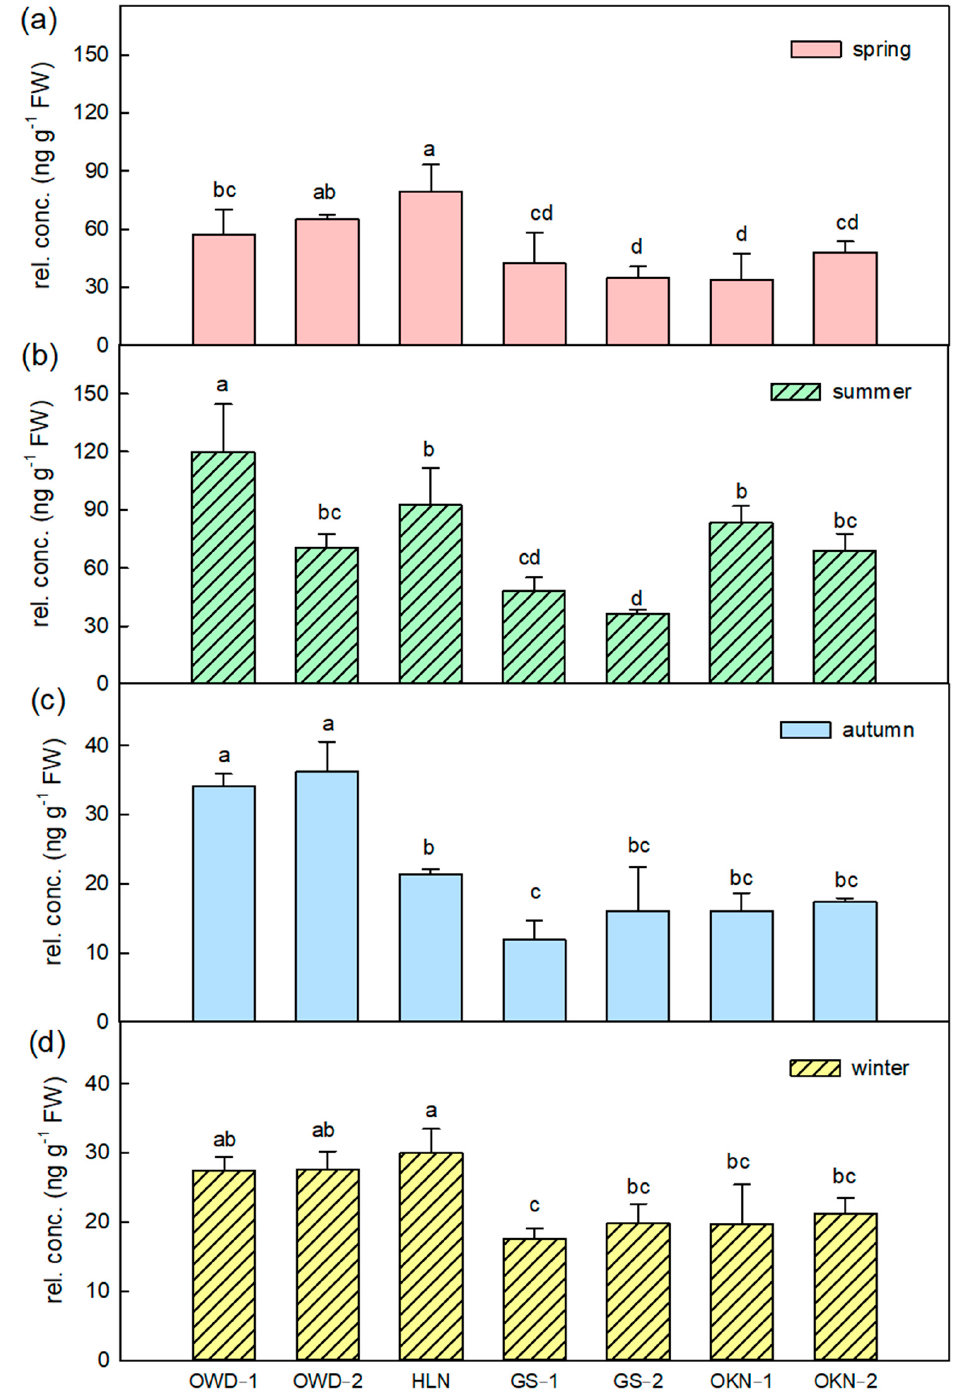
Figure 4. The β -ocimene variations in Citrus depressa fresh leaf among all accessions in each season, which is ( a ) spring; ( b ) summer; ( c ) autumn; and ( d ) winter. Each bar shows the average ( n = 3) of the relative concentration (rel. conc.) The error bar was calculated by standard errors, and the different letters show a significant difference (LSD p < 0.05).